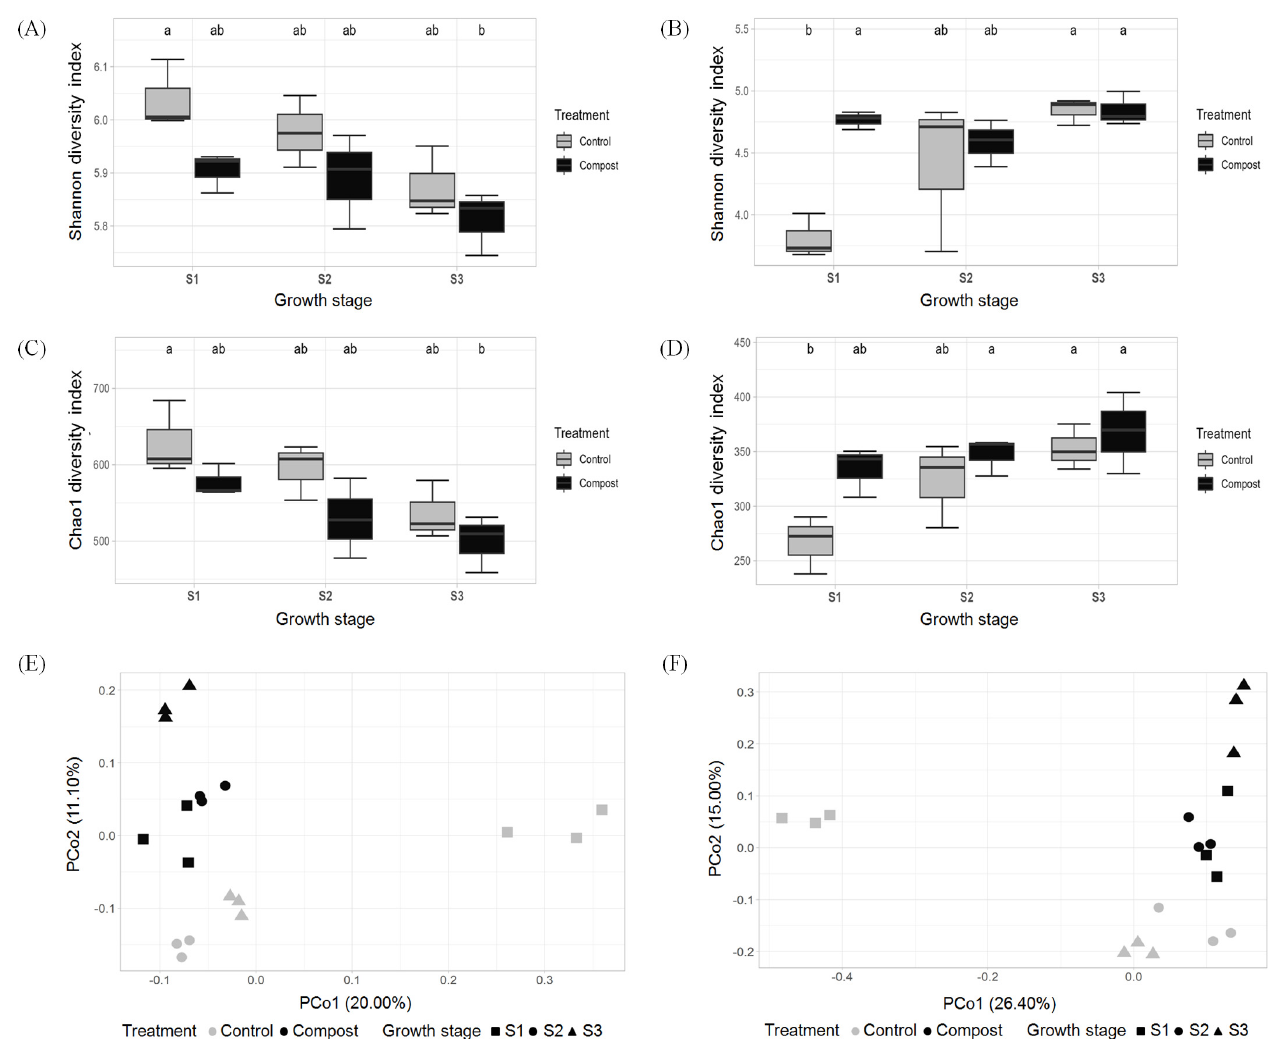
Figure 2. Microbial diversity analysis. Box plots represent alpha -diversity indices, including Shannon index of bacterial ( A ) and fungal communities ( B ); Chao1 index of bacterial ( C ) and fungal communities ( D ) and beta -diversity analysis of principal coordinates (PCoA) of bacterial ( E ) and fungal communities ( F ).